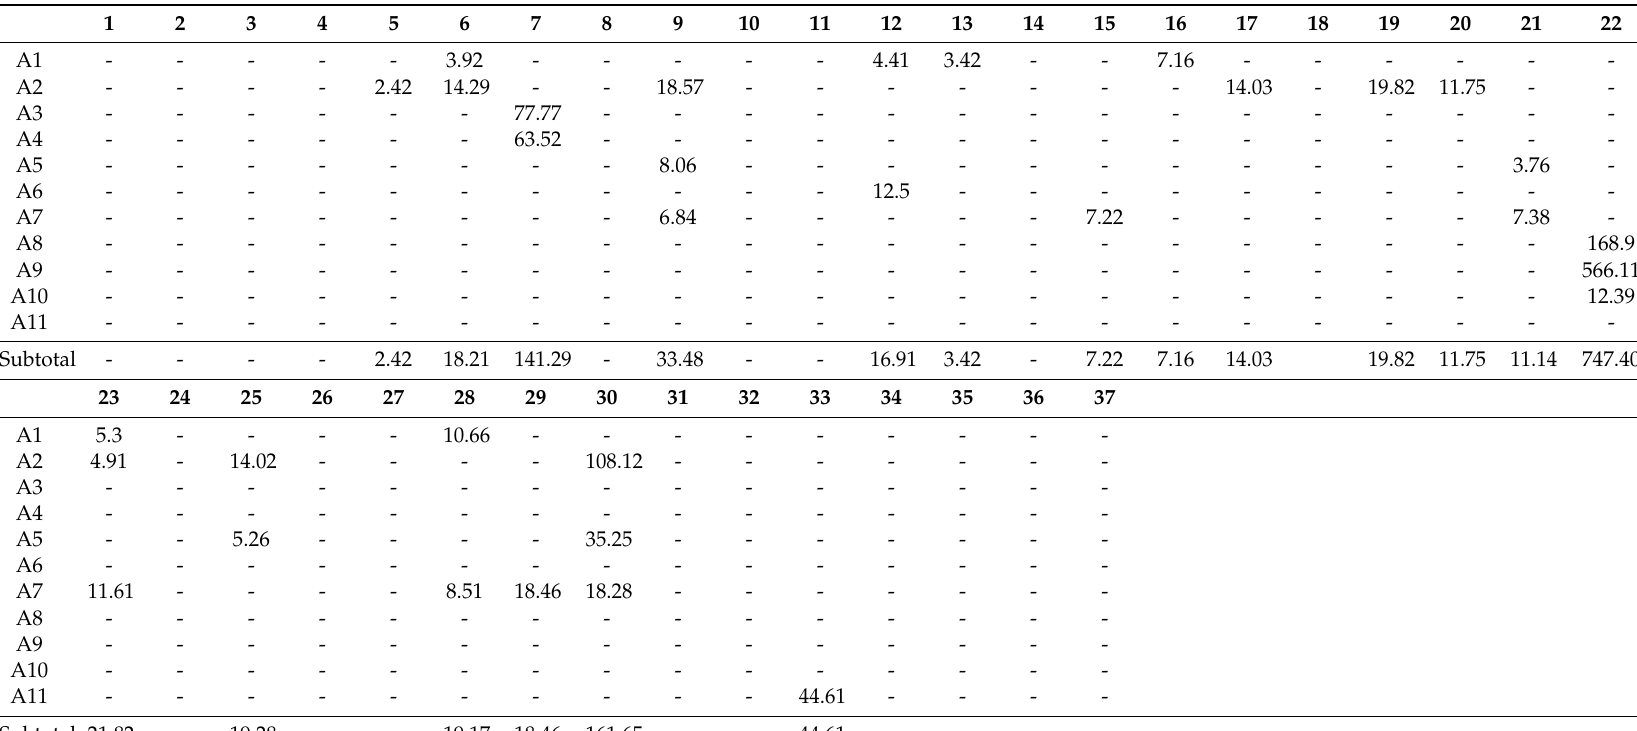
Table 5. Concentrations ( µ g/kg fresh weight (FW) equivalent of nonyl acetate) of volatile aldehydes in 37 mango